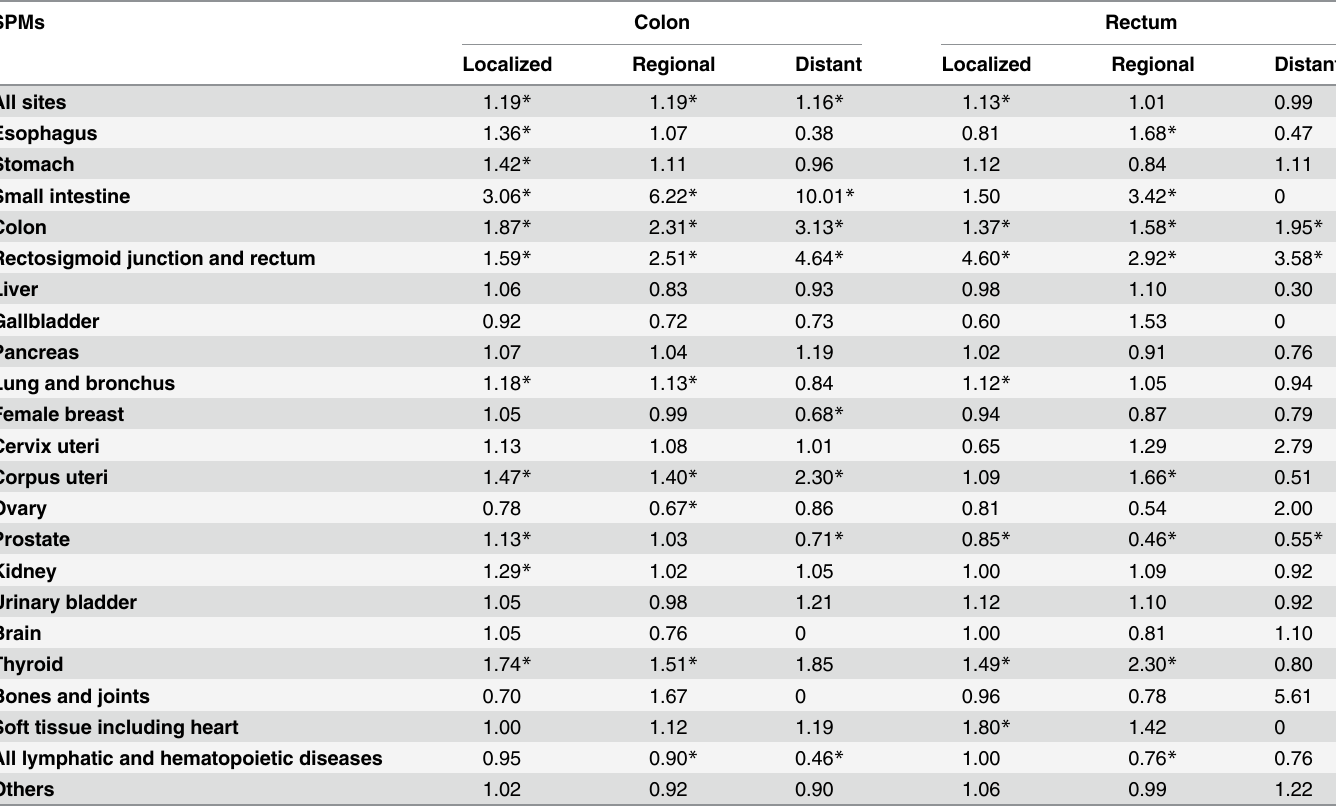
Table 5. SIRs of SPMs in colon and rectal cancer patients, by stage.